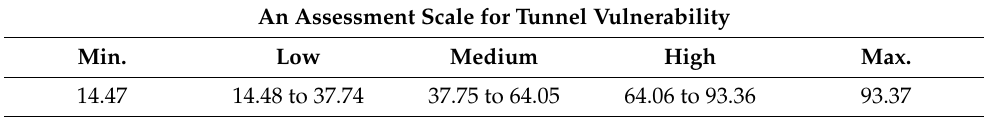
Table 17. The level of vulnerability for